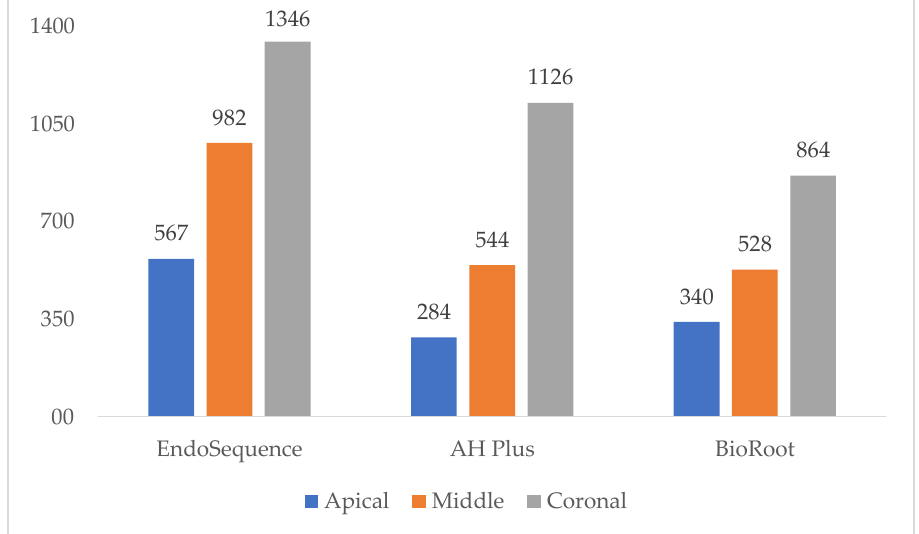
Figure 3. Mean tubular penetration depth by thirds.